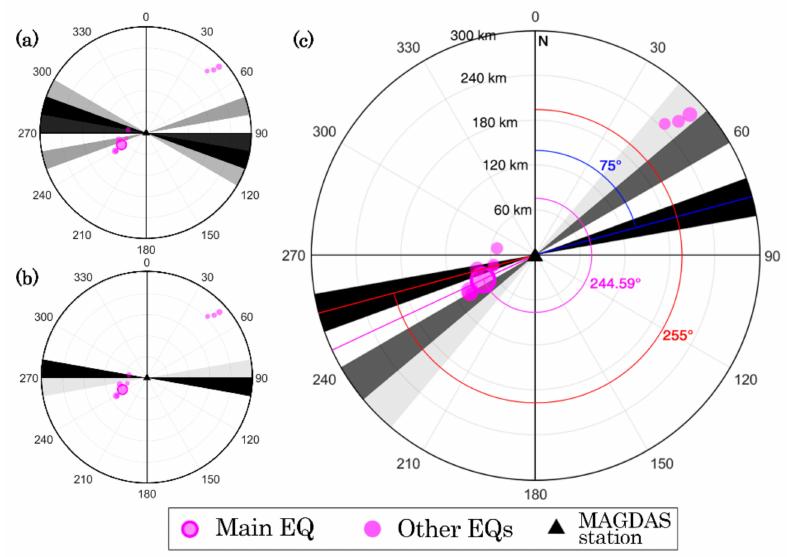
Figure 4. Azimuthal beams at CEB station on ( a ) 19th January 2012, ( b ) 21st January 2012, and ( c ) 20 January 2012 (the date of the precursor appearance in Figure 3). The circle sizes indicate the magnitudes of the earthquake. In ( c ), the angles between the true North (N) and the earthquake of interest, the first ϑ , and the second ϑ are written in magenta, blue and red,